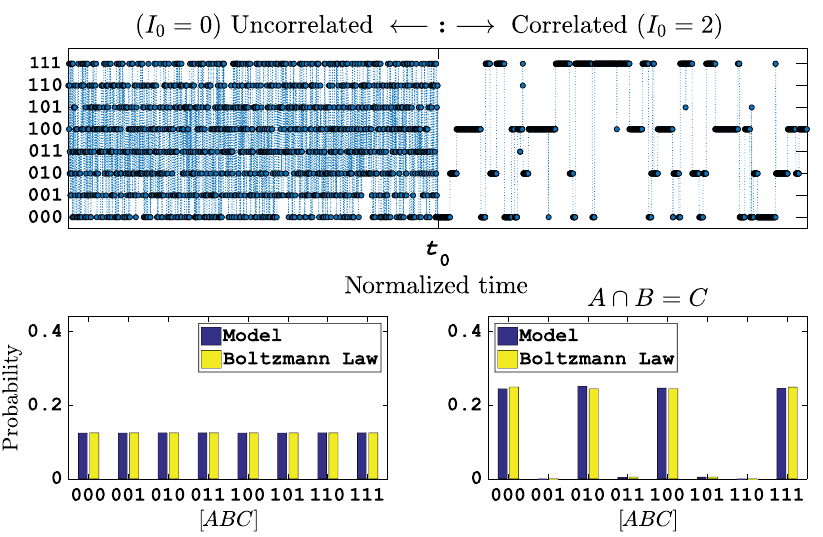
FIG. 7. Correlated p -bits, AND gate. When the interaction strength ( I 0 ) is zero, p -bits produce uncorrelated noise, visiting all possible states with equal probability. In this example, the interaction strength (pseudo inverse temperature) is suddenly increased from 0 to 2 as a step function at t ¼ t 0 , to effectively “ quench ” the network. This correlates the p -bits to produce the truth table of an AND gate (AND: A ∩ B ¼ C ). Note that after this quenching, the p -bits visit only the low-energy states corresponding to the truth table of the AND gate, and once the system is in one of the low-energy states, it tends to stay there for a while, until being kicked out by the thermal noise. The time averages of the uncorrelated and the correlated system are well explained by the Boltzmann law stated in Eq. (4). The total simulation uses T ¼ 4 × 10 6 steps to compare the results with the Boltzmann distribution, though only a fraction are shown in the upper panel for